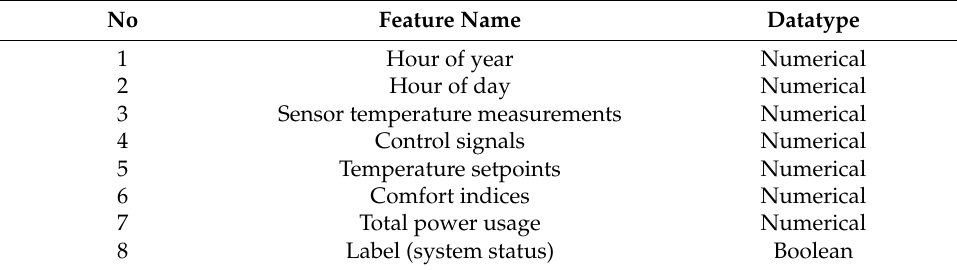
Table 3. Description of the common attributes category in the three log